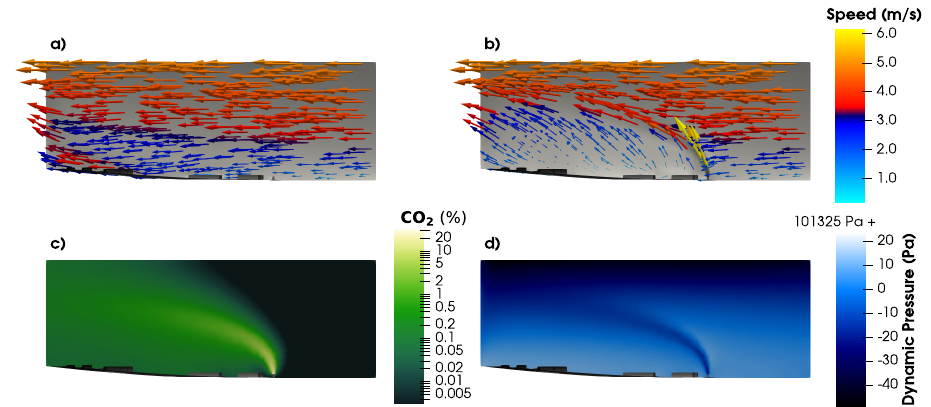
Figure 3. Simulation overview. Slice of the simulation domain parallel to the main wind flow, north-west ( − 1,1,0 ) , cut through the middle of the plume. The chimney is 10 m high, T 0 = 10 ◦ C, T c = 110 ◦ C and wind speed 5 m/s. The velocity values ( a ) before the plume sets on and ( b ) after. The ( c ) concentration of CO 2 is given as percentages of the total mass. The ( d ) dynamic pressure P − ρ gz is also shown.